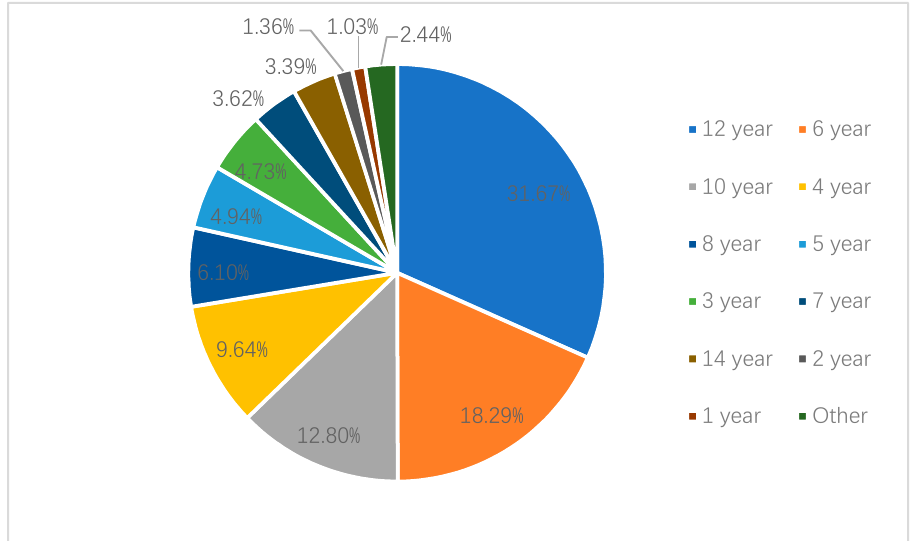
Figure 1. Recognized age criteria of national child restraint legislation by parents in Shanghai.